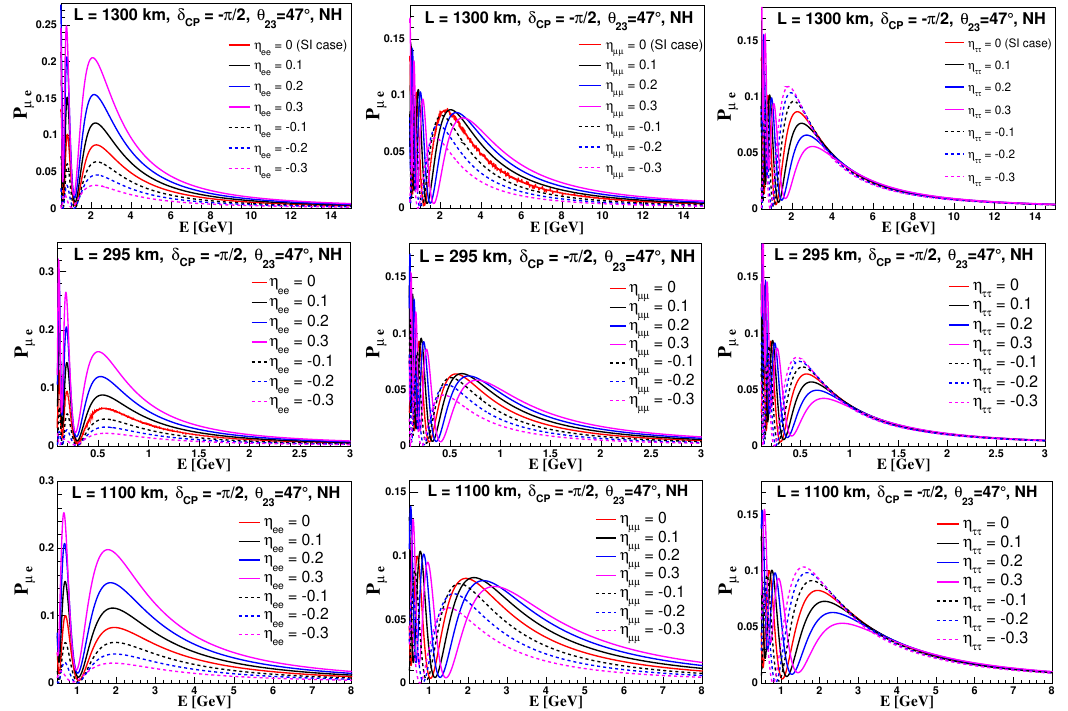
Figure 1 . The effects of η ee (left-column), η µµ (middle-column) and η ττ (right-column) on P µe at the baselines corresponding to DUNE (top-row), T2HK (middle-row) and T2HKK (bottom-row). Here, δ = − π /2, θ = 47 ◦ and true mass Hierarchy = NH. In all the plots, the red solid-curve is CP 23 for no-NSI case while other solid (dashed) curves are for positive (negative) NSI parameters.